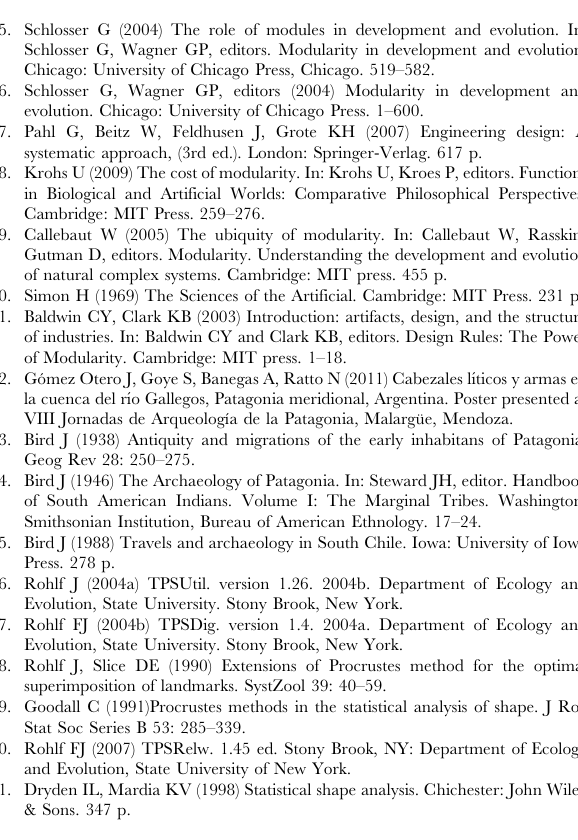
Table S1 Further details concerning each point. Classi- fication under the Bird’s system, qualitative and quantitative data regarding point’s size, IBS, TA and